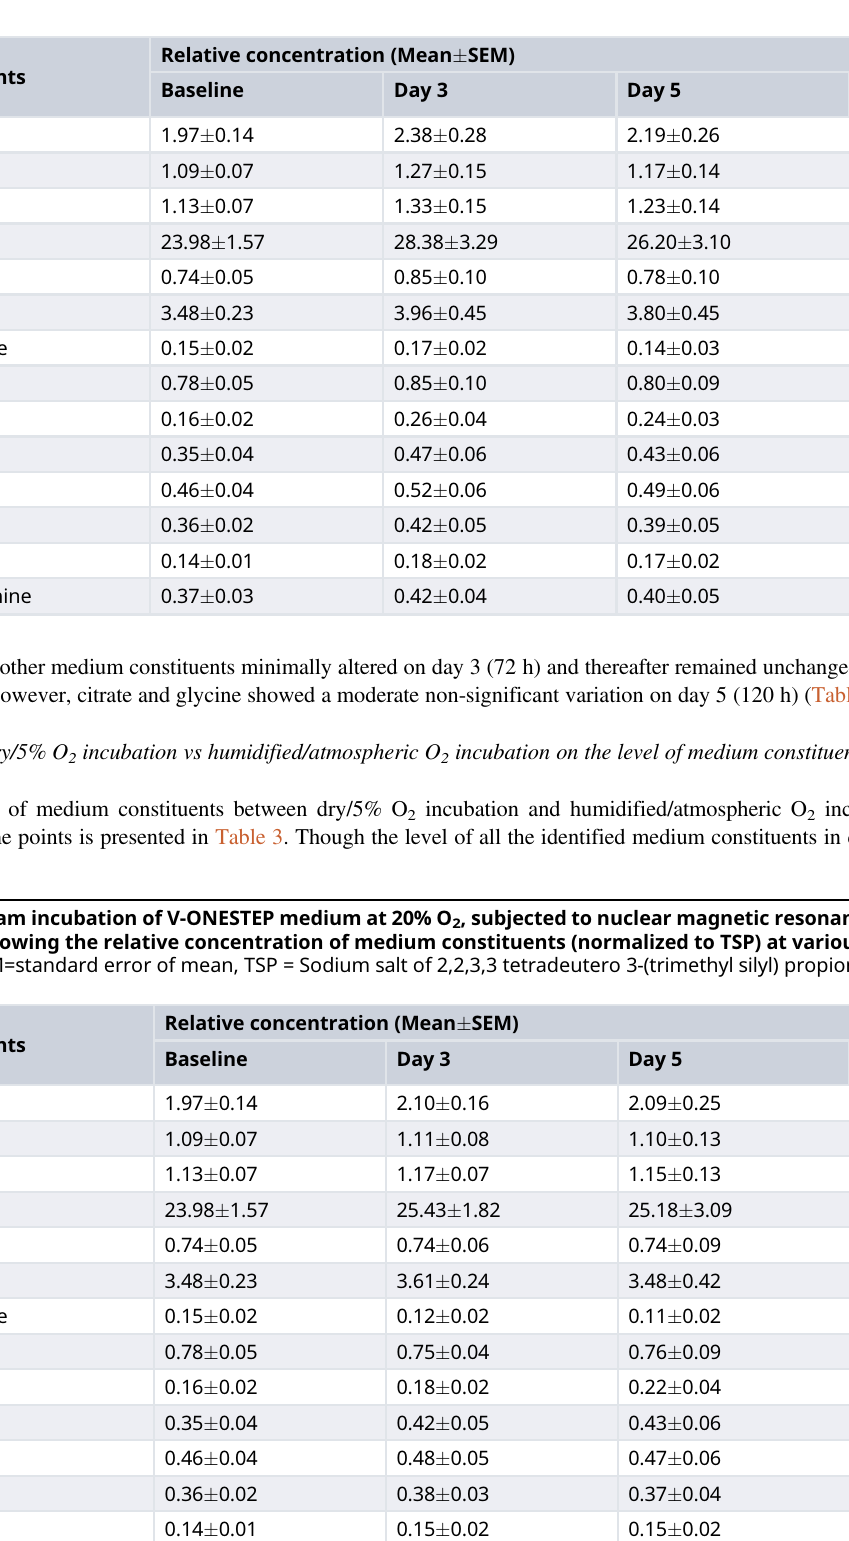
Table 1. Sham incubation of one-step medium at 5% O 2 , subjected to nuclear magnetic resonance (NMR) analysis showing the relative concentration of medium constituents (normalized to TSP) at various time points.